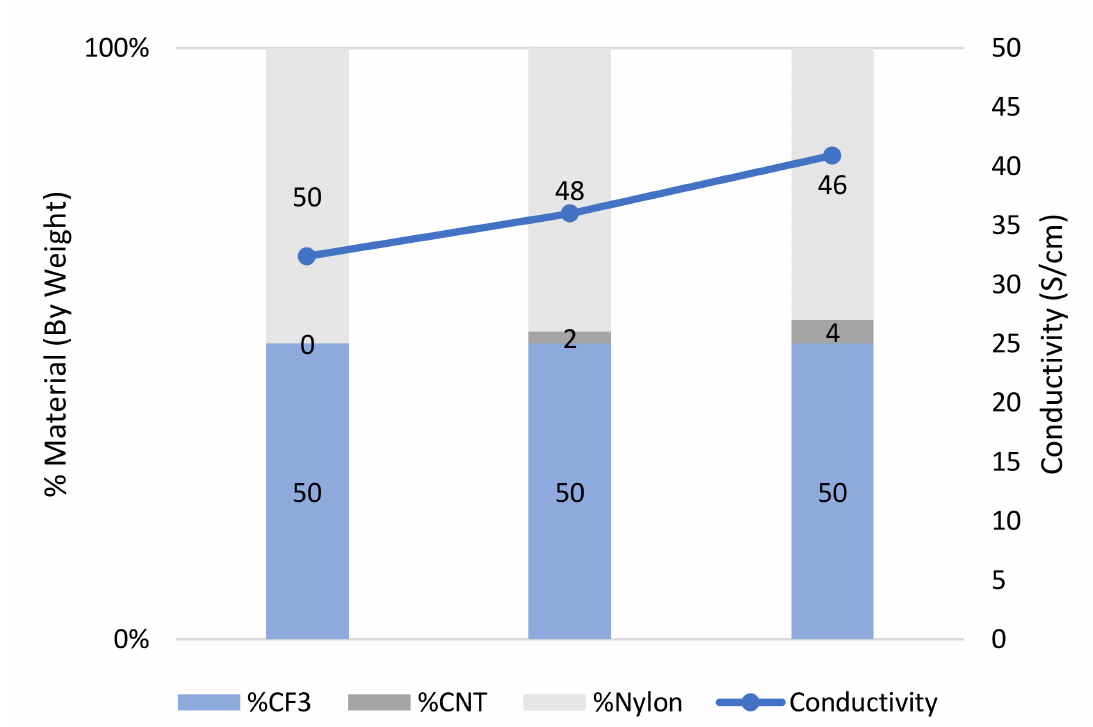
Figure 12. Electrical conductivity of the CF3 and CNT